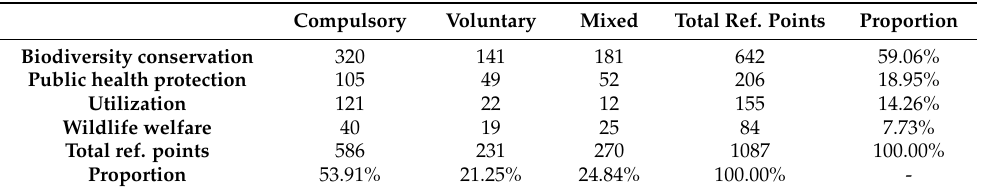
Table 5. Matrix Coding of Policy Objectives and Policy Tools.